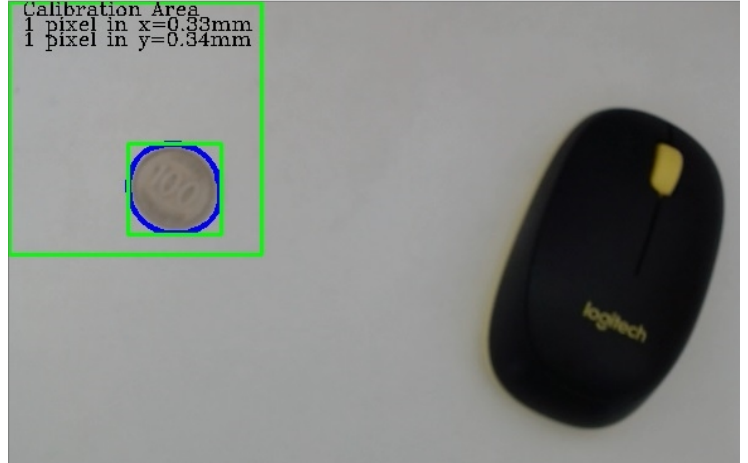
Figure 2. Calculate the physical size corresponding to each pixel on the x and y axes. The big green area is the calibration area. The blue line presents the contour of the object inside the small green box. For image data transmission, the network topology user datagram protocol (UDP) is used and set up. Message Queuing Telemetry Transport and Data Distribution Services provide real-time behavior, so they are considered to be